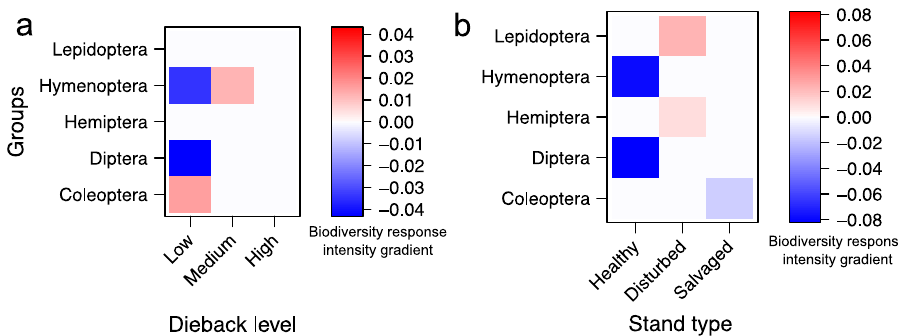
Fig. 8 Insect orders winning and losing from environmental conditions. Heatmap representation based on traitGLM analyses with LASSO penalty of insect orders ’ prevalence according to environmental conditions: a forest dieback level (i.e. low, medium and high) and b stand types (i.e. healthy, disturbed and salvaged). Negative and positive interactions and their intensity in terms of biodiversity response to environmental conditions for each of the fi ve most represented orders are highlighted by a continuous colour gradient spanning from blue to red, respectively. We found speci fi c responses for each insect orders ’ diversity in regards to dieback levels and stand types. For instance, the low prevalence of dipterans and hymenopterans observed at low dieback level while relatively high prevalence for coleopterans. However, hymenopteran prevalence was greater in forests of medium dieback level. Coleoptera was the only order with prevalence negatively impacted by salvage logging. Finally, disturbed plots showed a relatively high prevalence of both Lepidoptera